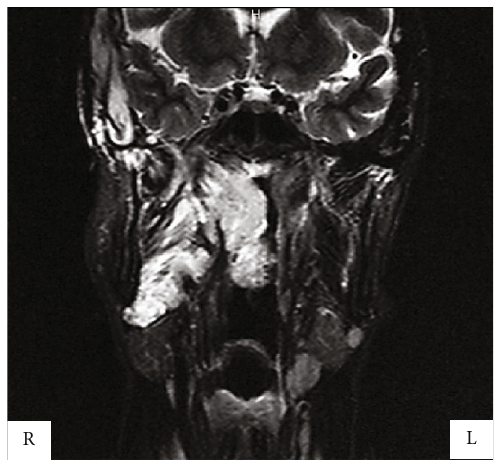
Figure 5: Short TI inversion recovery image showing a higher signal in the area of the lesions compared to the surrounding tissues.